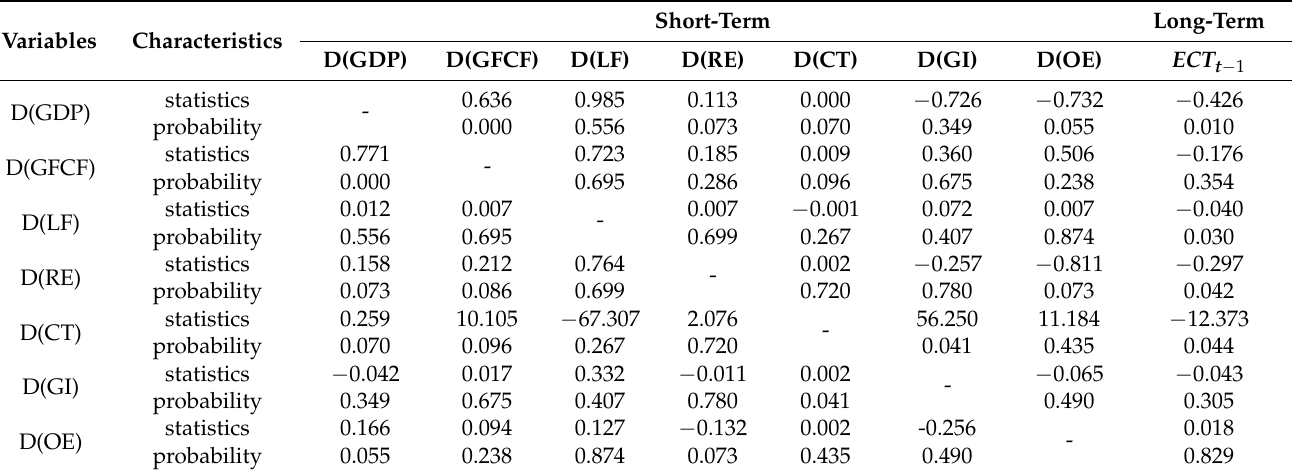
Table 8. The VECM Granger causality